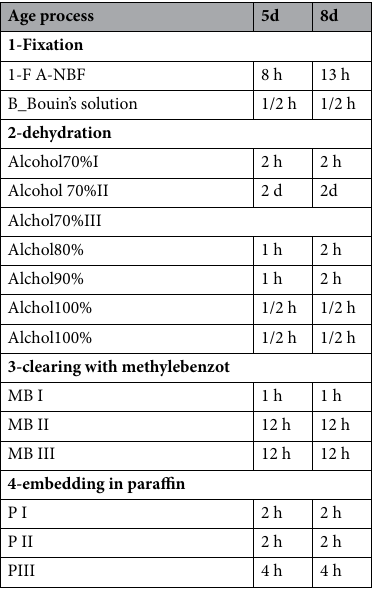
Table 1. The processing time of the samples in paraffin embedding techniques. NBF neutral buffer formalin, h hours, d days, MB I methyl bonzoate1, MB II methyl benzoate II, P I paraffin I, P II paraffin II, P III paraffin